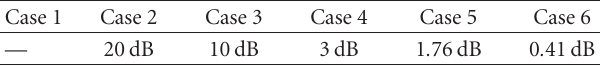
Table 2: Fairness ratio between the best and worst SINR